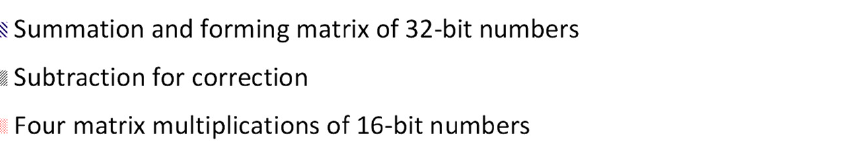
Figure 5. Percentage of time for different stages of the proposed scheme of 32-bit matrix multiplication depending on matrix size.